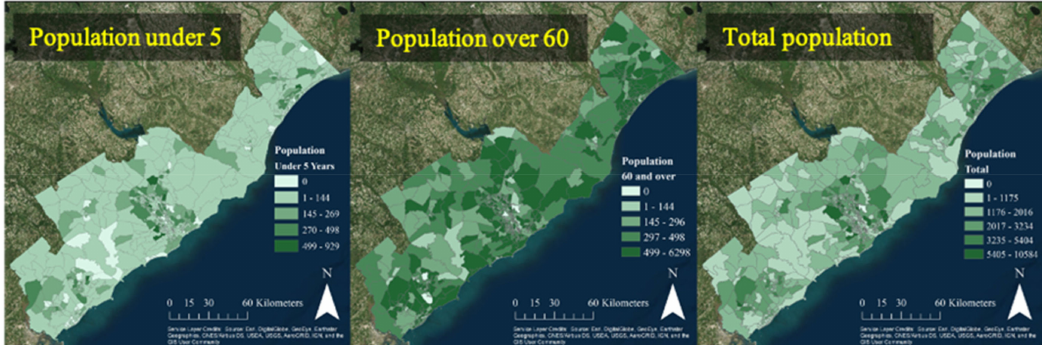
Figure 5. Population under 5, over 60, and total population for eight counties of interest in South Carolina, mapped by US Census block group [49,50]. Note that the color scale changes for the total population map versus the two sub– population graphs.